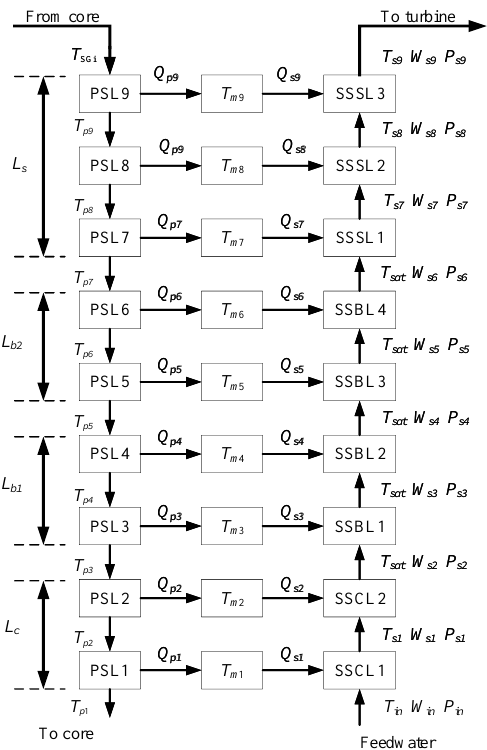
Figure 1. Node division of once-through steam generator.